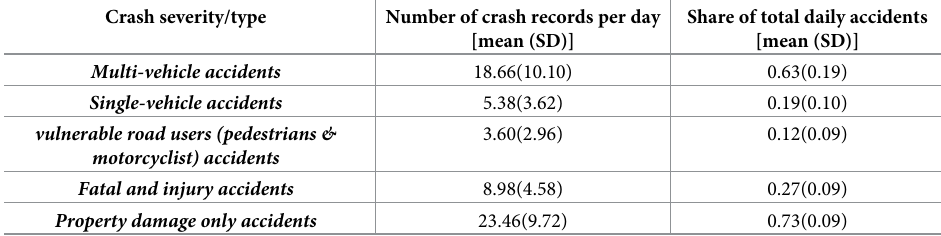
Table 1. Descriptive statistics of daily crash records in the study region.